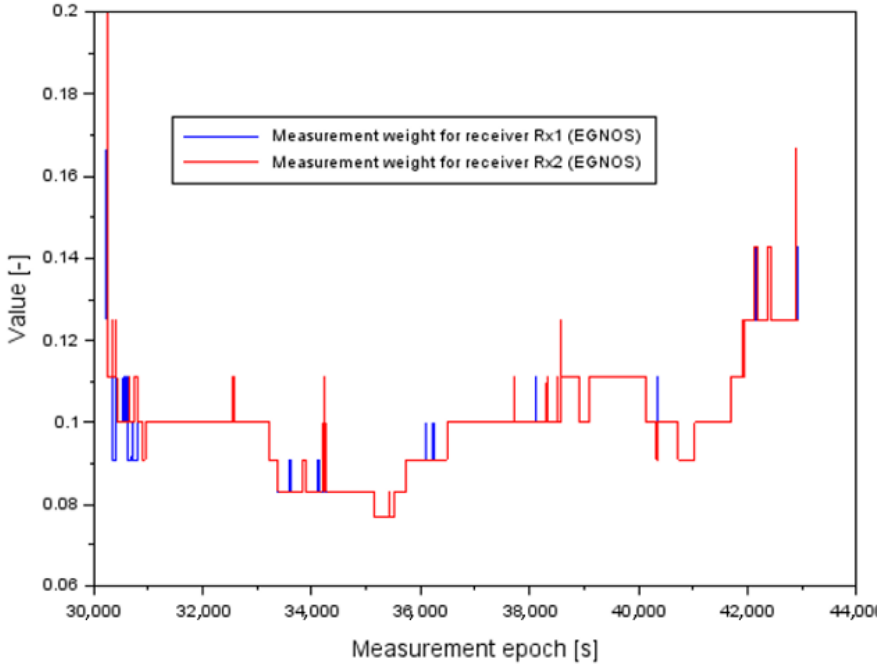
Figure 13. The results of measurement weights for EGNOS solution.